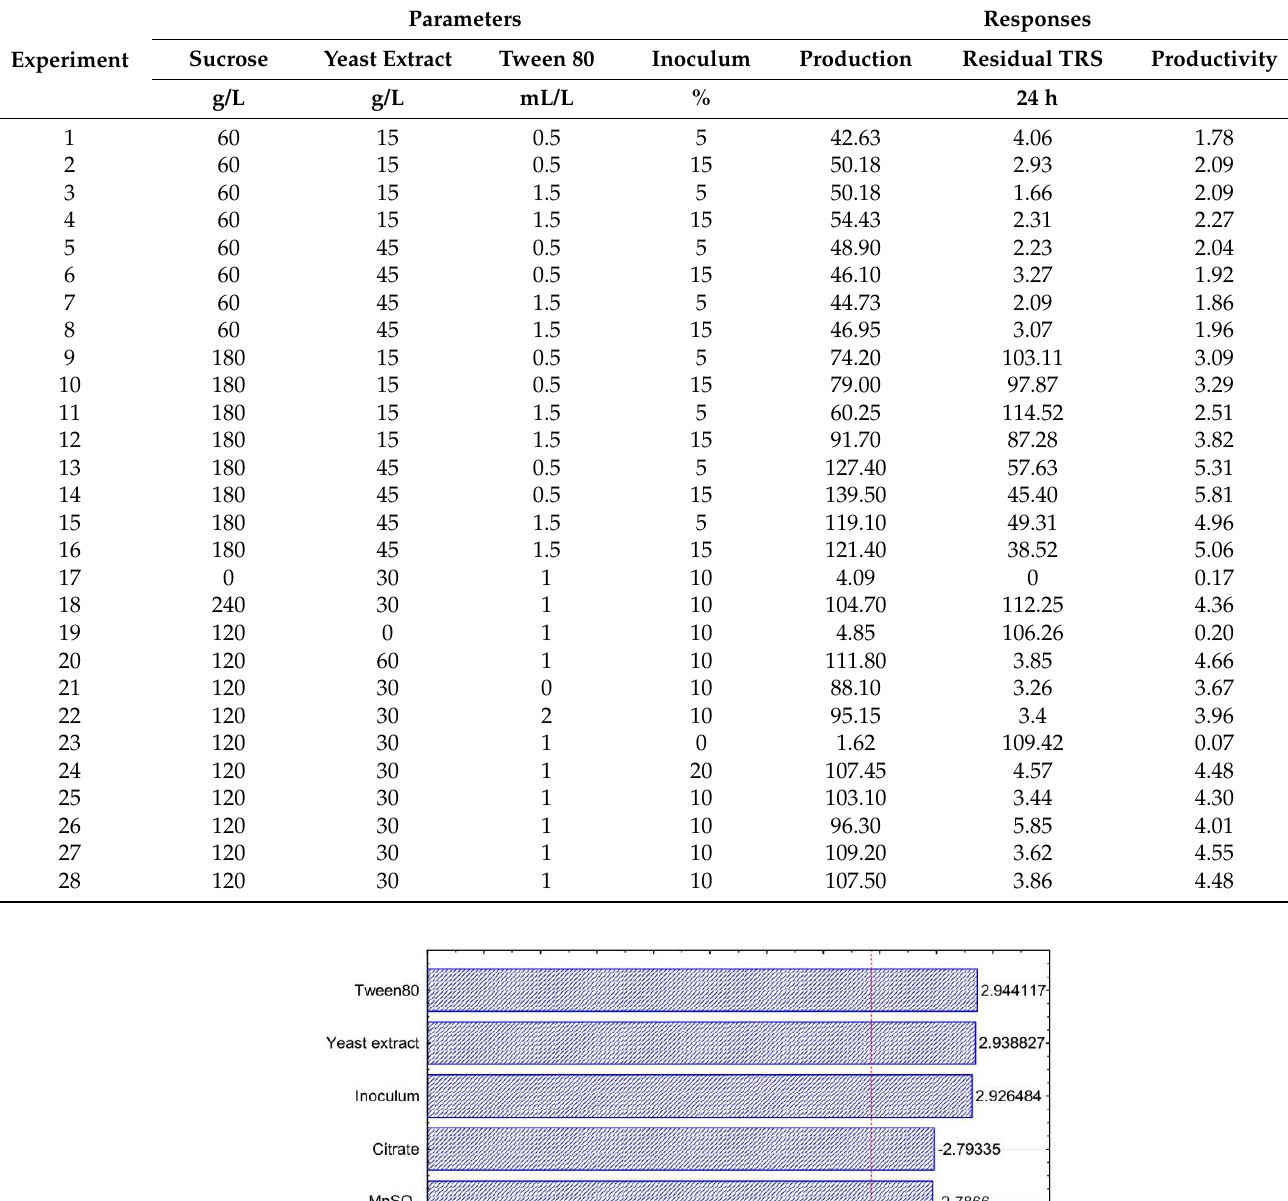
Table 4. Experimental central composite design matrix with real values and respective responses: production of lactic acid (g/L), residual total reducing sugar (residual TRS) (g/L) and productivity (g/L/h).